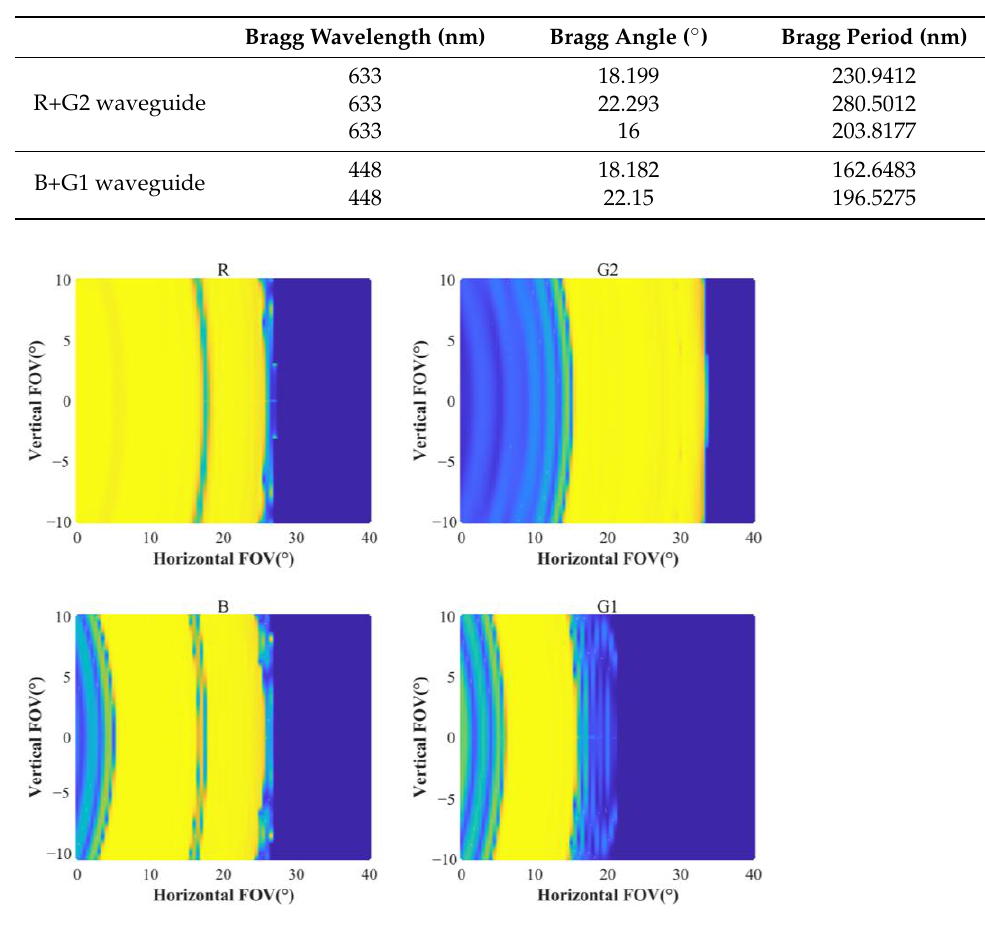
Figure 6. Efficiency distribution of horizontal FOV and vertical FOV in the R+G2 waveguide and B+G1 waveguide. The input wavelengths are 633 nm for red, 519 nm for blue and 448 nm for blue.